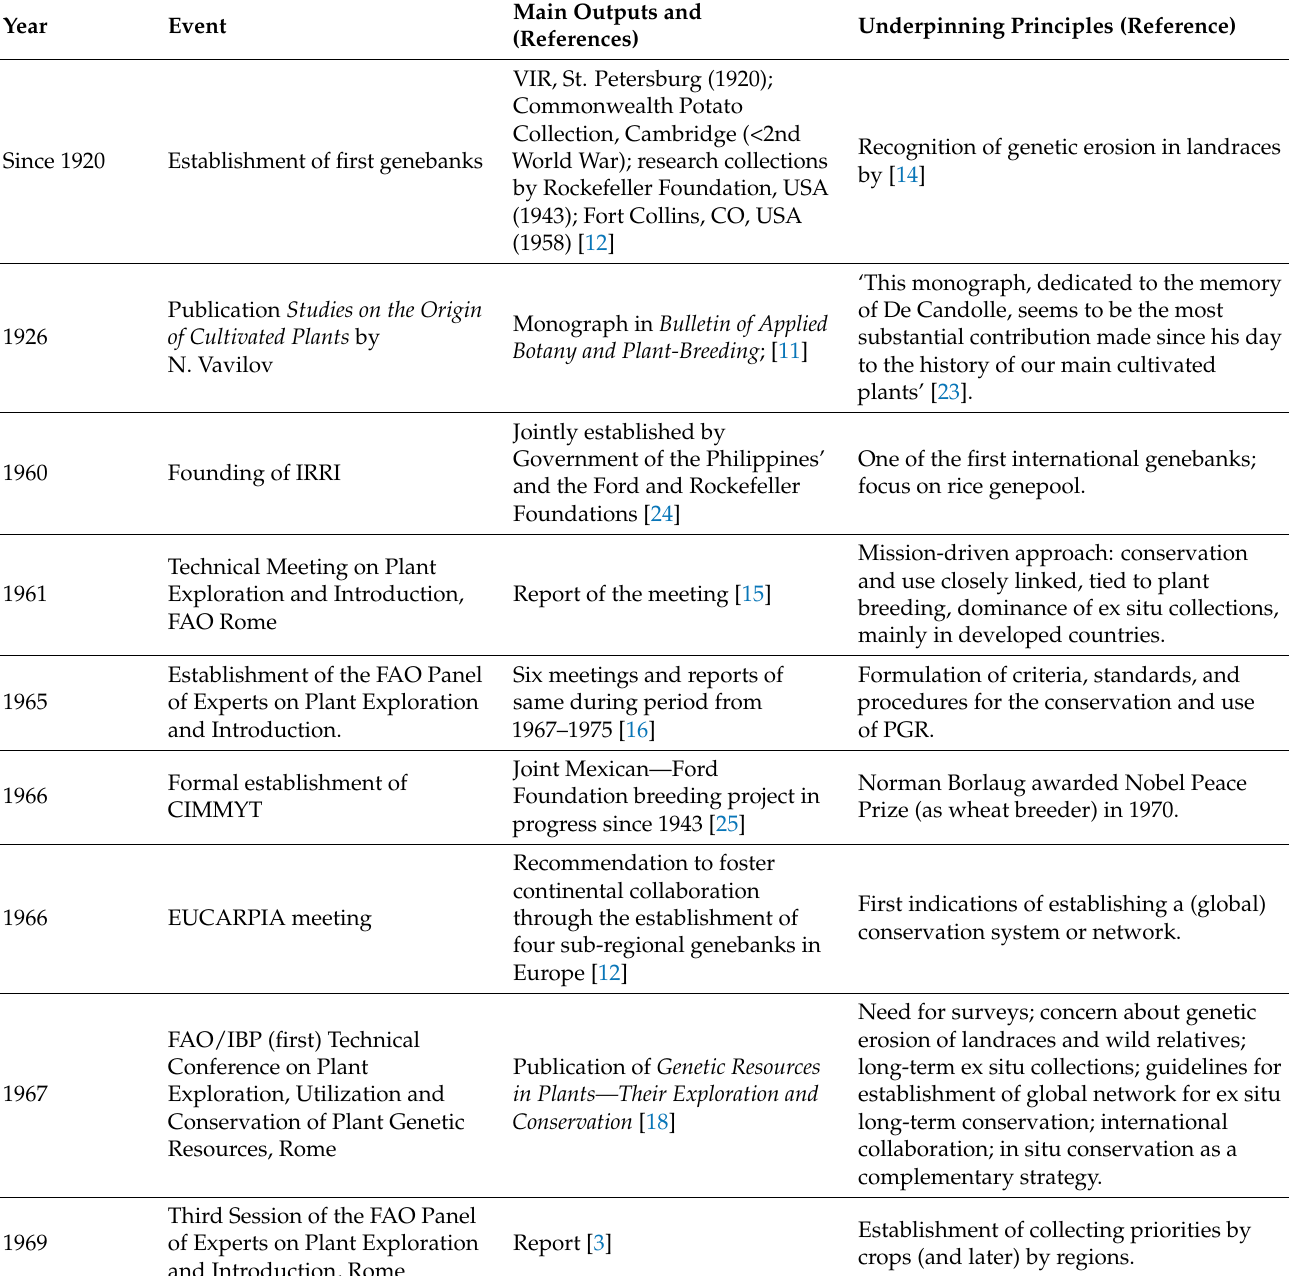
Table 1. Historical events of relevance to the establishment and evolution of the global PGRFA conservation, including the international network of base